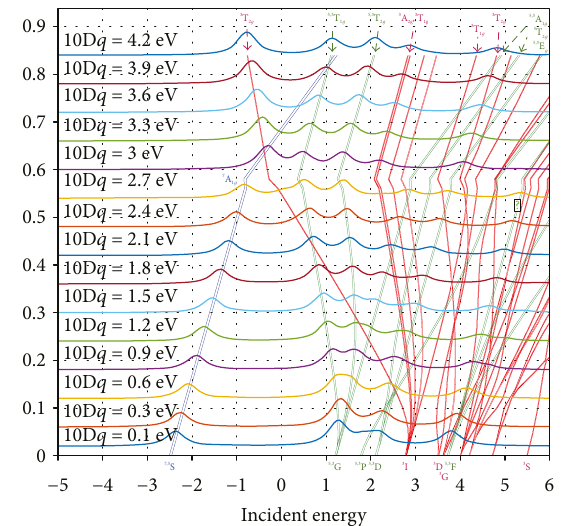
Figure 31: 1s XAS projection of a calculated 1s2p RIXS map for Mn 3+ ( 3d 4 ) with the corresponding ELD. The high spin to low spin transition at approximately 10D q ≈ 2 85eV can be recognised. In fact, there are two HS → LS transitions: in the ground and the intermediate